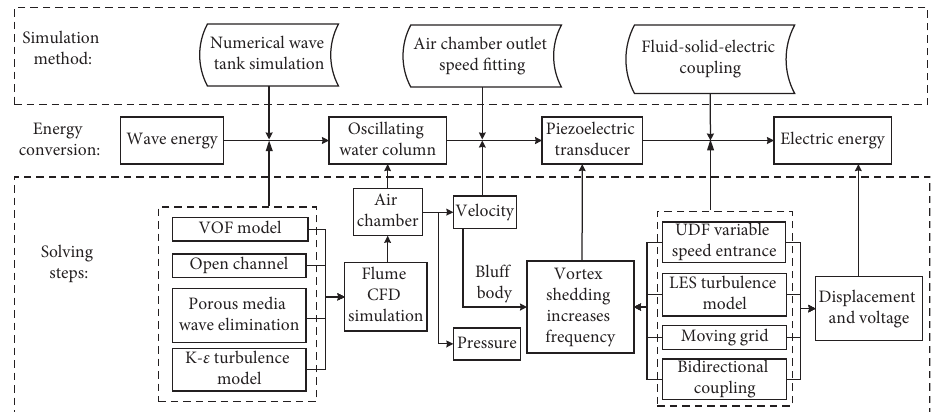
Figure 3: Schematic of the simulation process for the piezoelectric generator system.